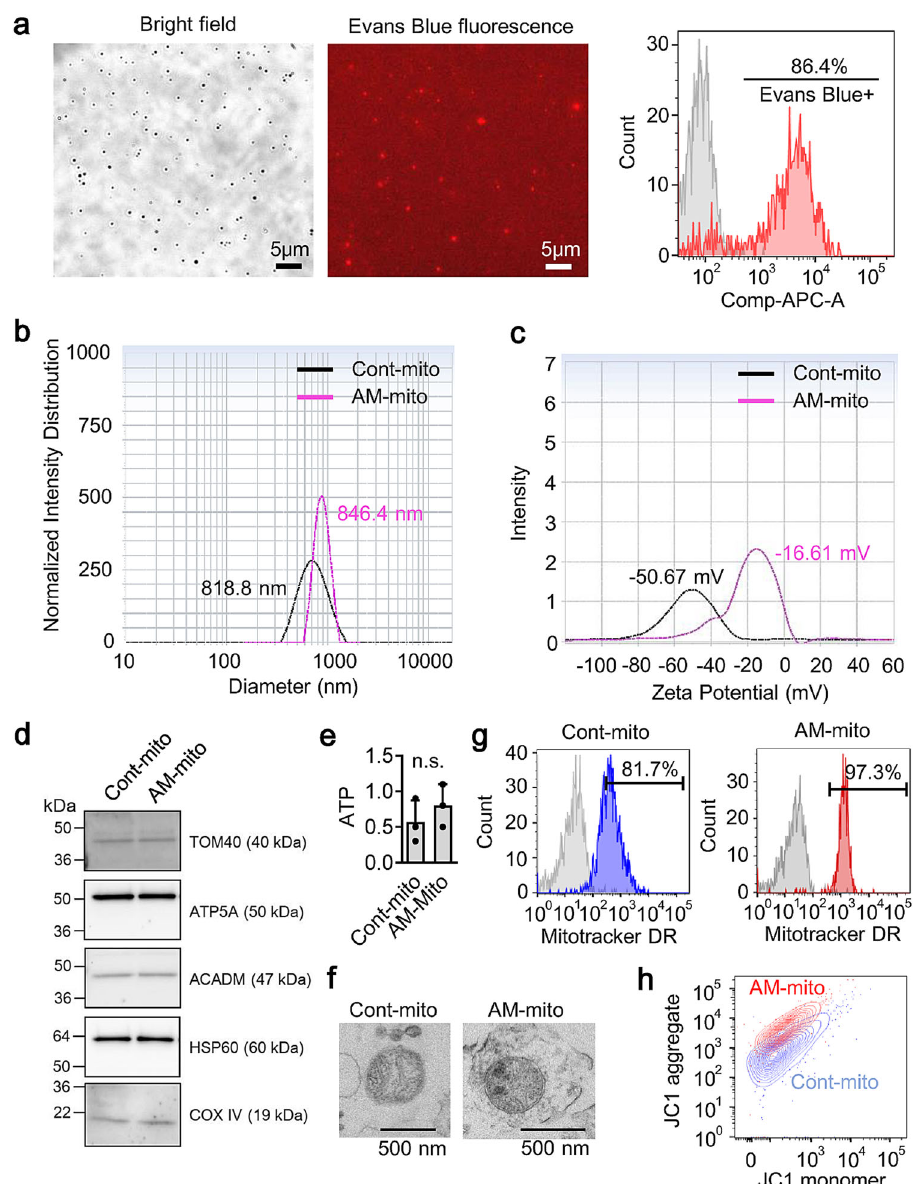
Fig. 2 MitoCoat with cationic lipid membrane. a Mitochondria wereisolated from intact cerebral cortexof male C57BL/6Jmiceandsuspendedin mitochondria functioning buffer. Then the inverted emulsion method was applied to them. FACS analysis revealed that approximately 86% of mitochondria were wrapped by DOTAP/DOPE vesicles. Evans blue was mixed with mitochondrial functioning buffer to track mitochondrial encapsulation. b Particle size of arti fi cial membrane- coated mitochondria (AM-mito) was approximately 846.4nm. c After coating, zeta potential of mitochondria was changed from − 50.67mV to − 16.61mM. d Western blot con fi rmed that mitochondrial proteins such as TOM40, ATP5A, ACADM, HSP60, and COX IV were well preserved in AM-mito equivalent to control mitochondria. e ATP content (nmol per mg protein) was not different between control mitochondria and AM-mito ( n = 3). P = 0.3987, unpaired t -test (two-tailed). Results were expressed as mean±SD. f TEM images showed no clear morphological change in mitochondria following arti fi cial membrane coating. g FACS analysis showed higher purity of mitochondria following coating process around 97% in comparison of control mitochondria around 81%. h FACS analysis showed that JC1 mitochondrial membrane potential became slightly higher in AM-mito compared to control Primary neuron cultures . Primary neuron cultures were prepared from cerebral Oxygen-glucose deprivation (OGD) and reoxygenation . OGD experiments were cortices of E18-day-old Sprague-Dawley rat or C57BL/6J mouse embryos. Brie fl y, performed using a specialized, humidi fi ed chamber (Heidolph, incubator 1000, cortices were dissected and dissociated using papain dissociation system (Wor- Brinkmann Instruments, Westbury, NY) kept at 37 o C, which contained an anaerobic thington Biochemical Corporation, LK003150). Cells were spread on plates coated gas mixture (90% N 2 , 5% H 2 , and 5% CO 2 ). To initiate OGD, culture medium was replaced with deoxygenated, glucose-free Dulbecco ’ s modi fi ed Eagle medium (Life with poly-D-lysine (Sigma, P7886) and cultured in Dulbecco ’ s modi fi ed Eagle Technology, 11966-025). After 2h challenge, cultures were removed from the anae- medium (NBM, Life Technology, 11965-084) containing 25 mM glucose, 4mM robic chamber, and the OGD solution in the cultures was replaced with maintenance glutamine, 1 mM sodium pyruvate, and 5% fetal bovine serum at a density of medium. Cells were then allowed to recover for 24h for neurotoxicity assay. 2× 10 5 cells/mL (1mL for 12 well format, 0.5 mL for 24 well format). At 24h after seeding, the medium was changed to Neurobasal medium (Invitrogen, 21103-049) supplemented with B-27 (Invitrogen, 17504044) and 0.5mM glutamine. Cells were cultured at 37 °C in a humidi fi ed chamber of 95% air and 5% CO 2 . Over 95% of In vivo focal ischemia model . Male C57BL6 mice (11 – 12 weeks, Jackson purity of neuron cultures was determined by MAP2 staining in our previous study. Laboratories) were deeply anaesthetized with iso fl urane (5% to 1.5%) in 30%/70%